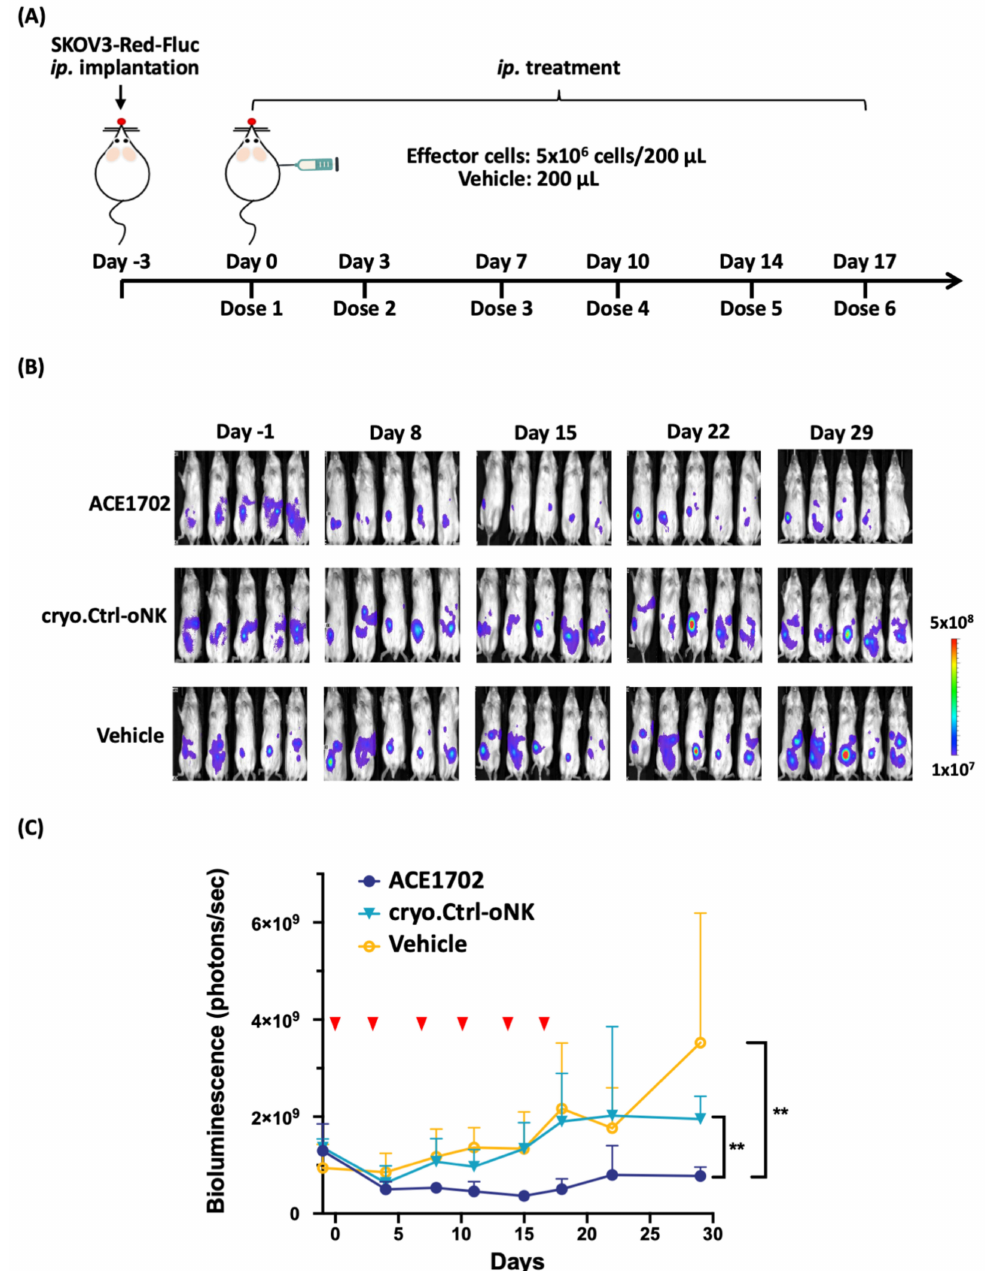
Figure 6. ACE1702 exhibits anti-tumor potency to HER2 + cancer cells in vivo. ( A ) Dosing schedule was illustrated. ( B ) The bioluminescence images of tumor burden in ACE1702-, cryo.Ctrl-oNK- and Vehicle-treated mice were captured by Ami HTX spectral instrument and analyzed by Aura software. ( C ) The bioluminescent signals of each timepoint for ACE1702-, cryo.Ctrl-oNK- and Vehicle-treated mice were presented by mean values ± SD. Red arrow heads indicate dosing of ACE1702, cryo.Ctrl-oNK and Vehicle only. Differences between 2 groups were examined by two-way ANOVA. p < 0.05 is considered as statistically significant. **, p <